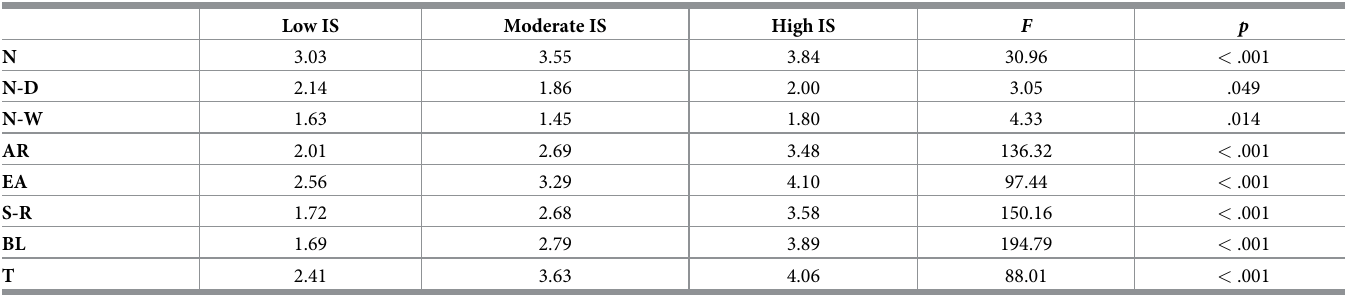
Table 1. Final cluster centroids of three IS clusters.